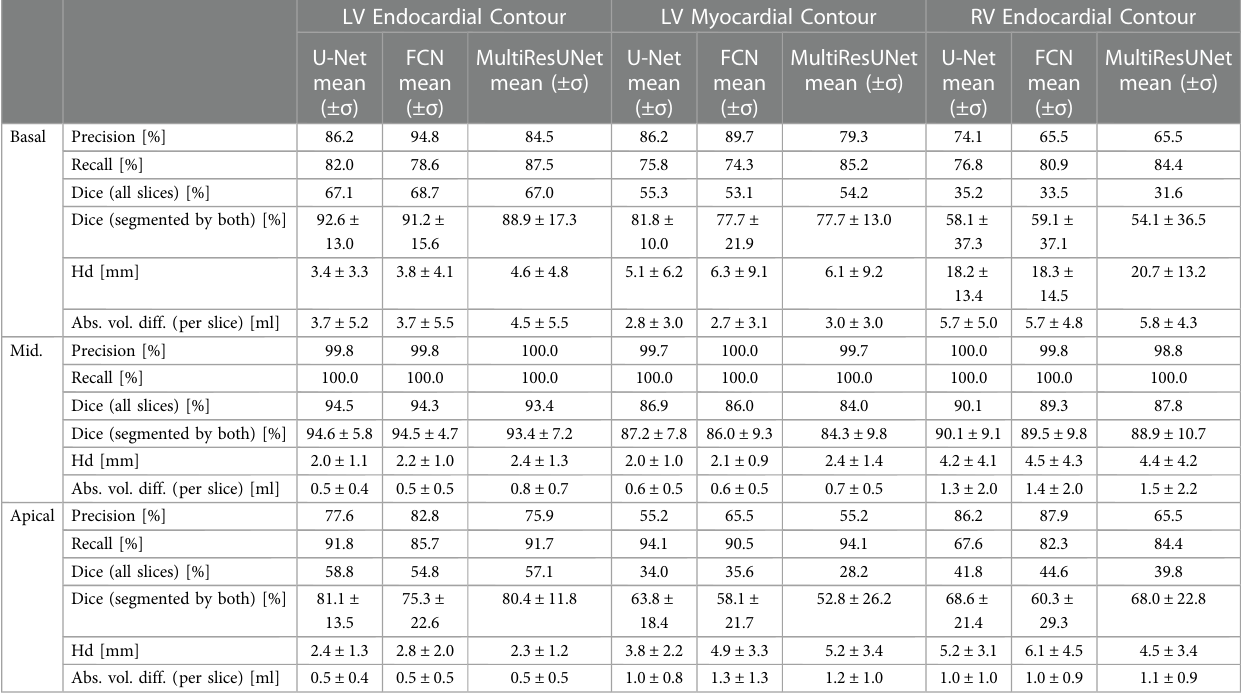
TABLE 3 Comparison of convolutional neural networks by segmentation metrics subdivided by contour entity and slice